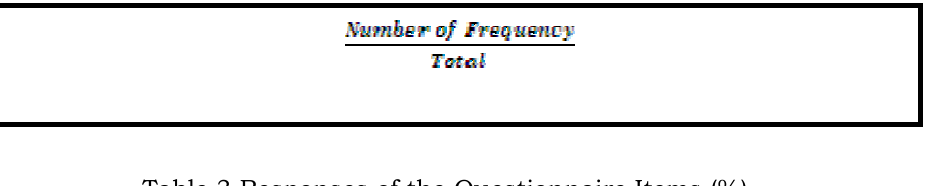
Table 3 Responses of the Questionnaire Items